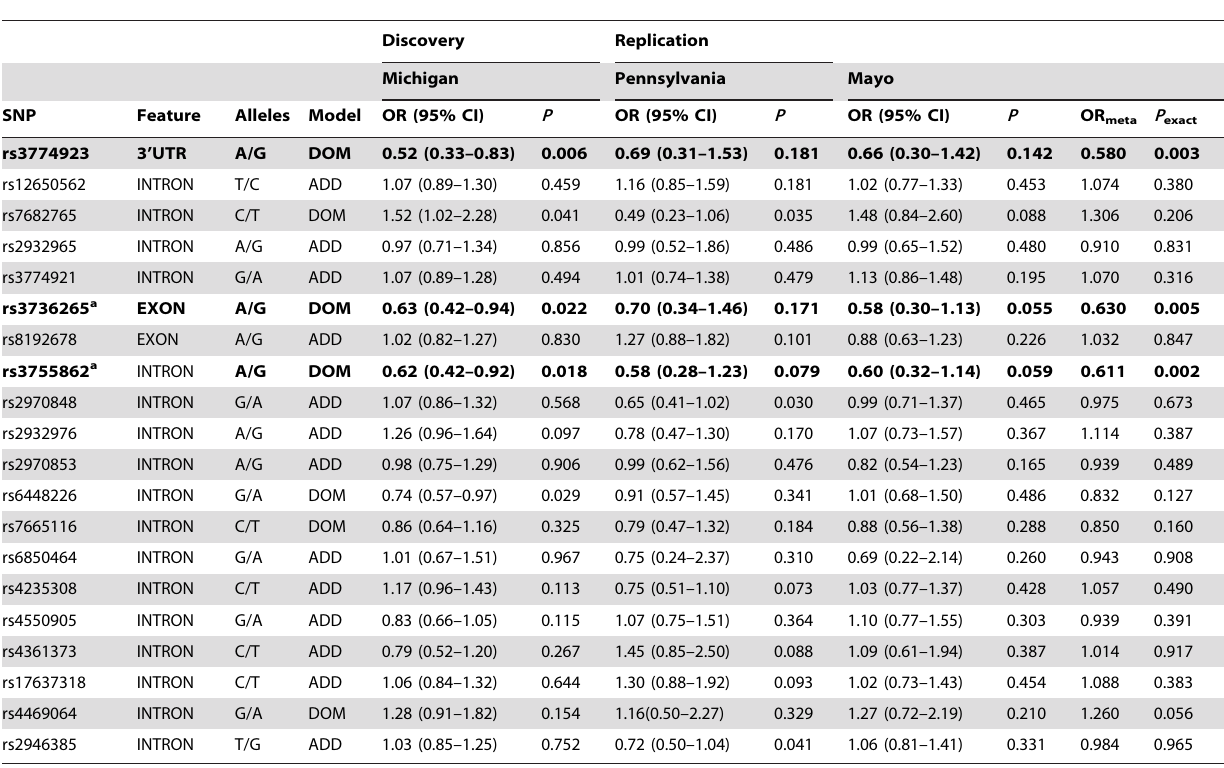
Table 2. Association results of PPARGC1A SNPs for NV AMD in three cohorts and in meta-analysis using multivariable